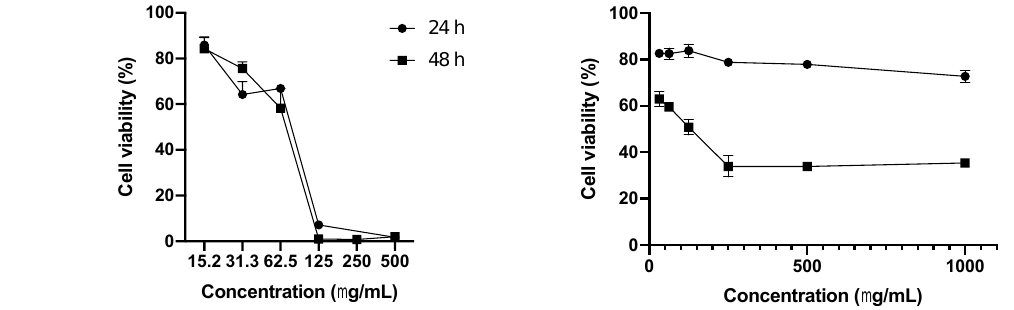
concentration. Treatment of WiDr cells with 5-FU